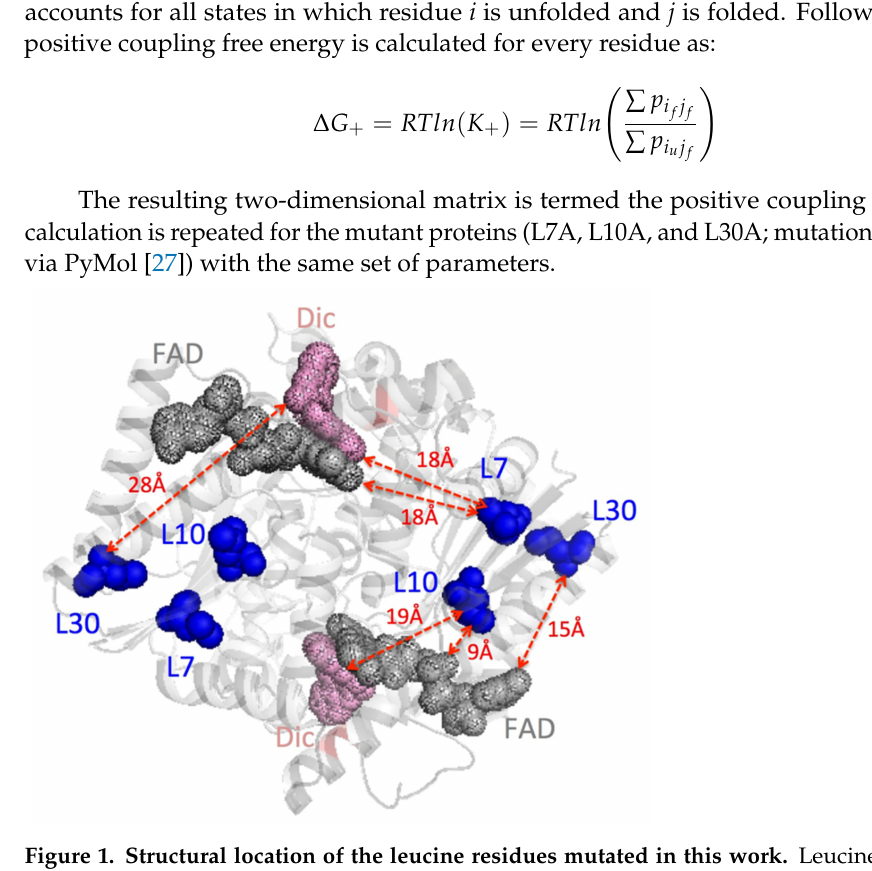
Figure 1. Structural location of the leucine residues mutated in this work. Leucine residues are indicated in blue. FAD is indicated in grey and Dic in pink. The figure was generated using the structure with PDB code 2F1O [25]. Solvent-accessible surface areas for L7, L10 and L30 are 0.3 ± 0.2%, 0.4 ± 0.2% and strictly 0%, respectively, using GetArea (http://curie.utmb.edu/getarea. html: accessed on 1 October 2019). Shortest distances between Leu residues and FAD and Dic molecules are indicated with red dashed